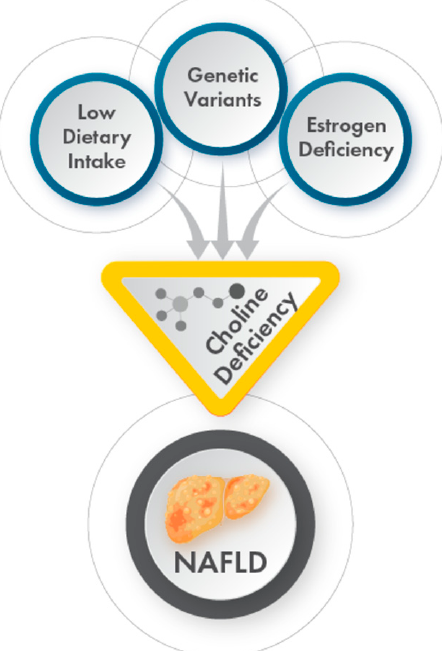
Figure 4. Diets low in choline, variants in genes involved in endogenous choline production, and estrogen deficiency may trigger a chronic choline-deficient state, which may increase the risk of developing NAFLD. Individuals possessing more than one of these factors are expected to be at greater risk of developing a choline-deficient state. Other factors, such as pregnancy and gut dysbiosis, may also affect choline bioavailability.